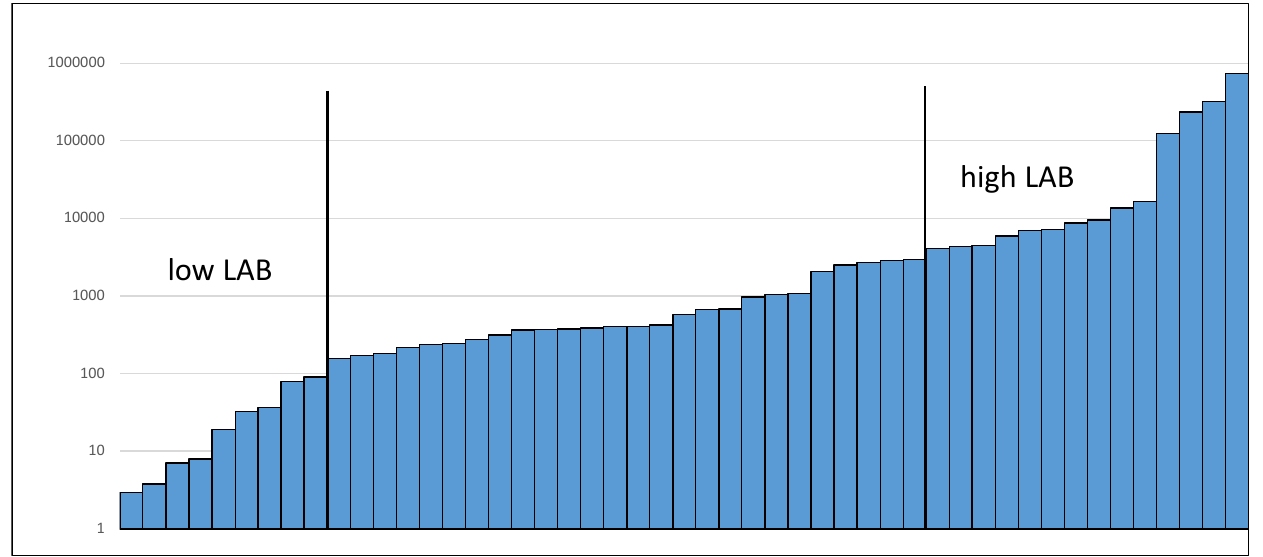
Figure 1. Distribution of LAB at baseline.